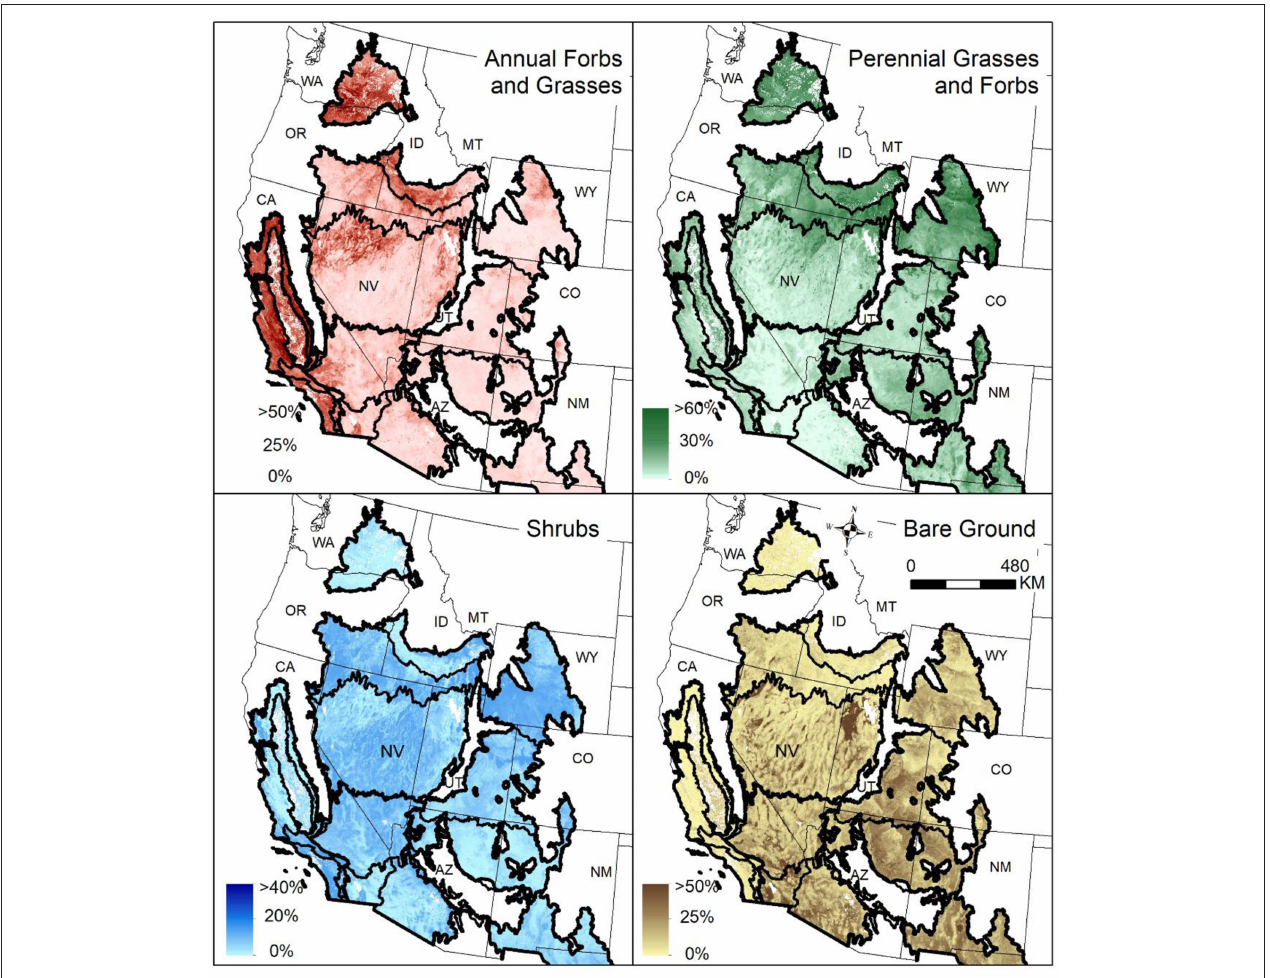
FIGURE 6 | Continuous land cover maps of annual forbs and grasses, perennial forbs and grasses, shrubs, and bare ground averaged for 2017 (modified from Jones et al., 2018). Water, snow/ice, cropland, developed, and wetland areas have been excluded using the National Land Cover Database (NLCD) (2014). regionally, and the relative proportion of shrubs vs.